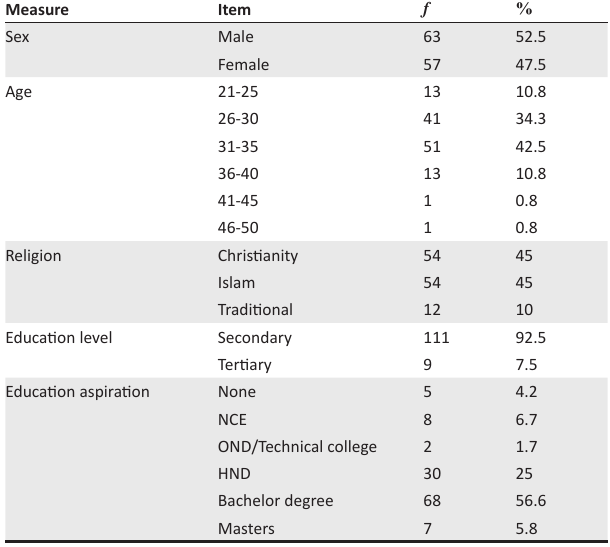
TABLE 3: Profile of respondents - children (non-TMPs ( n = 120).